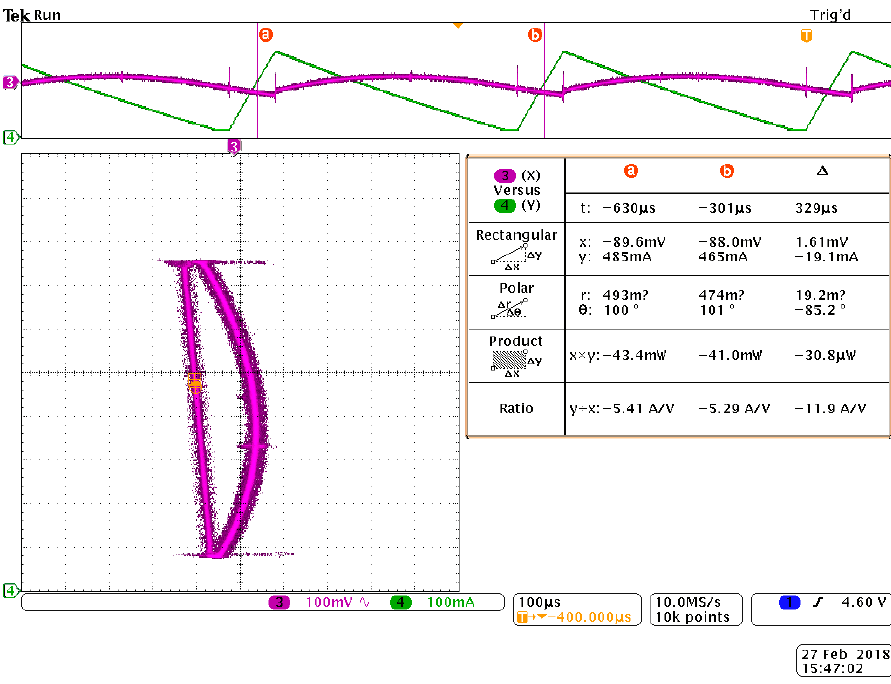
Figure 16. The simulated bifurcation diagram of the boost DCM converter: V out = f ( V g ).